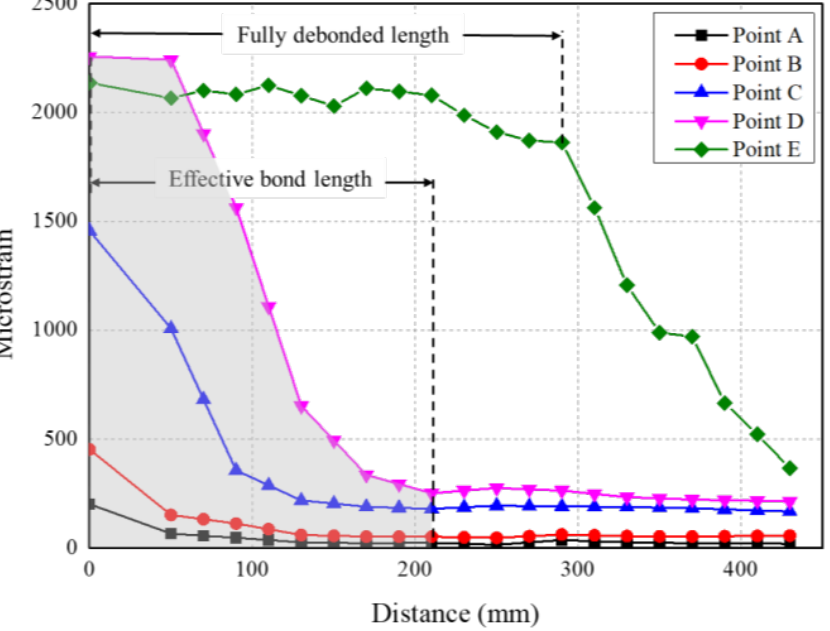
Figure 7. FRP strain distribution of MT-3 at each load point.